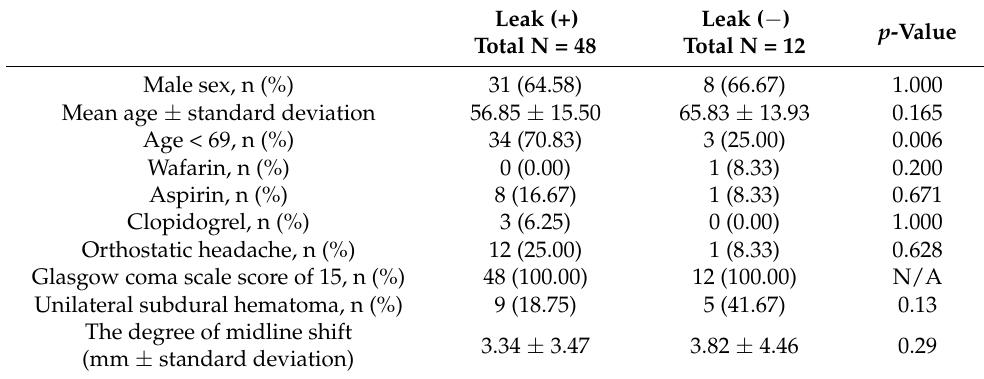
Table 1. Statistical Analysis of Parameters for Patients with Cerebrospinal Fluid Leaks and Those without Leaks among a Cohort of Patients with Nontraumatic Intracranial Subdural